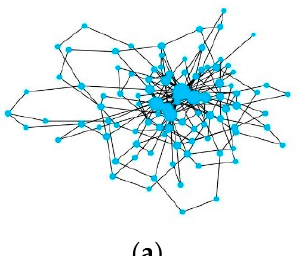
Figure 2. Number of layers of the graph convolution network versus the number of nodes covered (when 100 £ n ): ( a ) input graph; ( b ) one-layer graph convolution (red); ( c ) two-layer graph con- volution (purple and red).